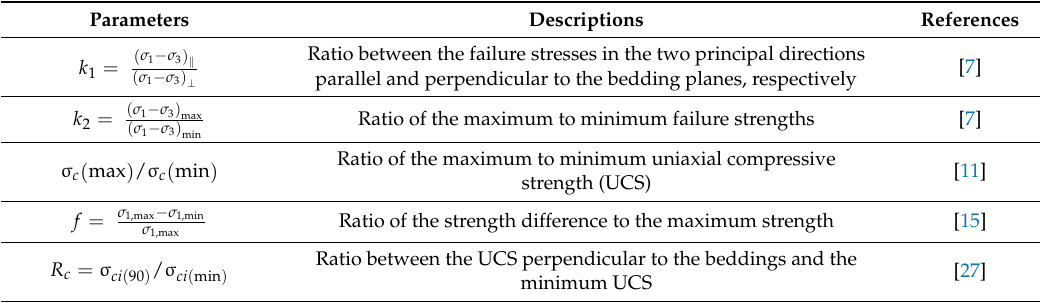
Table 1. Different parameters to describe the degree of anisotropic failure